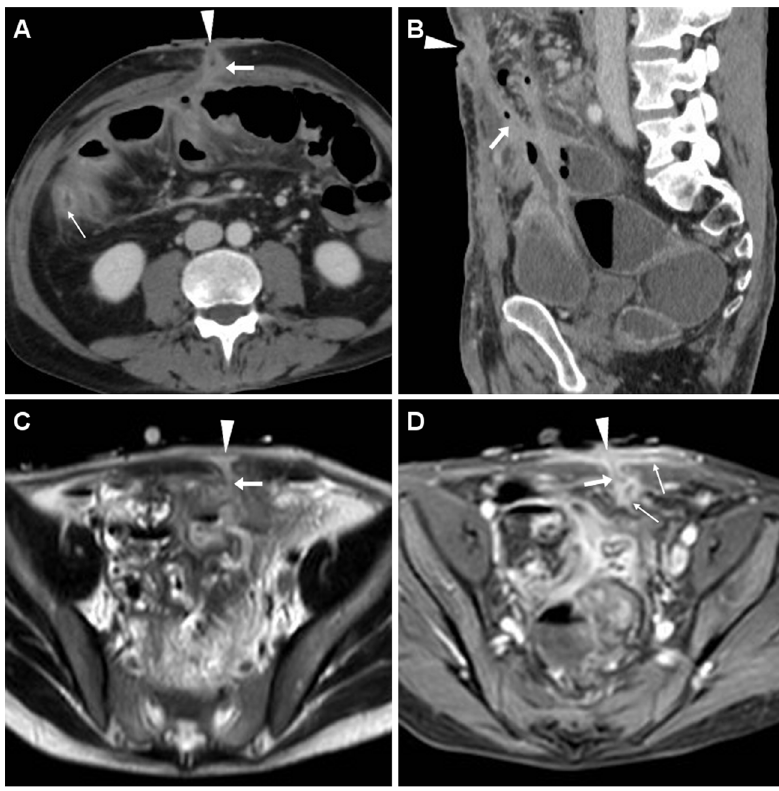
colectomy with cecal-rectum anastomosis, with corresponding MRI (T2- weighted image C , fat-suppressed post-contrast T1-weighted image D ) appearance of fluid-filled track (arrows) with peripheral enhancement (thin arrows). Prominent inflammation also affected the skin surrounding the EFO (arrowheads) and at inner aspect of the ECF: the latter corresponded endoscopically to the anastomotic site and was treated by positioning of an over-the-scope clip, allowing ECF resolution